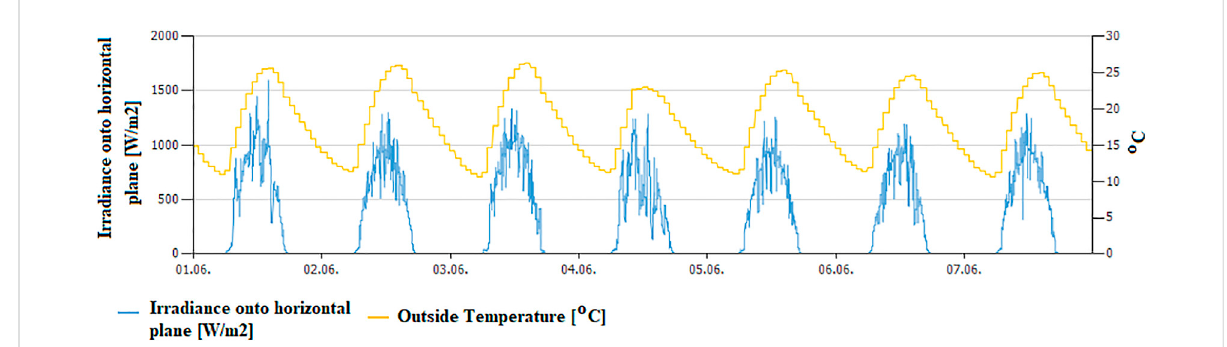
FIGURE 1 Irradiance onto horizontal and outside temperature variation for the fi rst week of June.